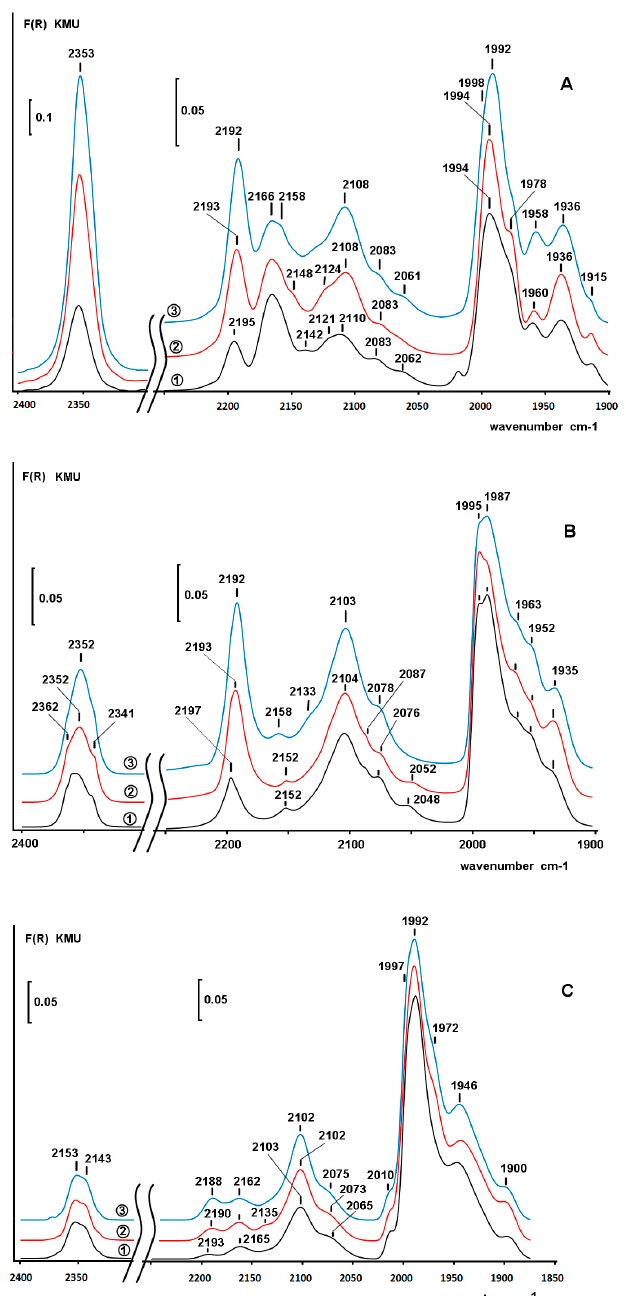
Figure 9. Difference IR spectra of CO adsorbed at RT on the Pd/ZS before ( A ), and after treatment with H 2 + water solution of phenol ( B ); spectra of Pd/ZS after mild reduction with H 2 at 200 °C ( C ). CO pressure: 5 Torr—curve 1; 20 Torr—curve 2; 50 Torr—curve 3. F(R)—Kubelka–Munk function (Kubelka–Munk units).